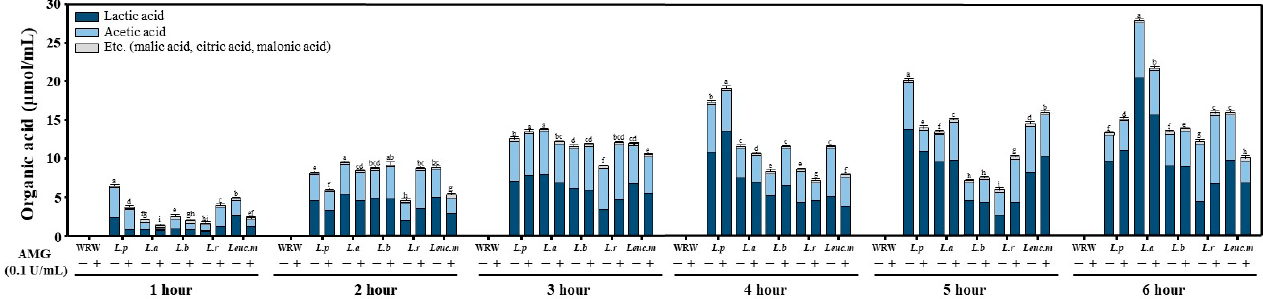
Figure 3. Analysis of changes in the organic acid composition during lactic acid fermentation. The organic acid concentration of the fermented rice water during lactic acid fermentation was analyzed every hour. In the enzyme-treated group, 0.1 U/mL of the treatment was applied. Different letter in the same time zone means significantly different.